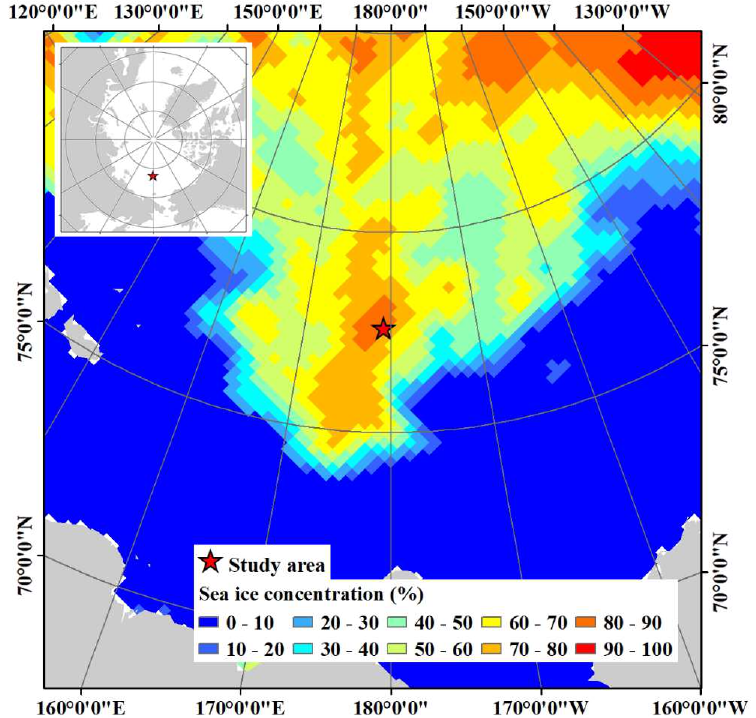
Figure 1. Location of our study area and surrounding sea ice condition on August 14, 2017 retrieved from the daily sea ice concentration data from Special Sensor Microwave Imager/Sounder (SSMIS) passive microwave data [34].